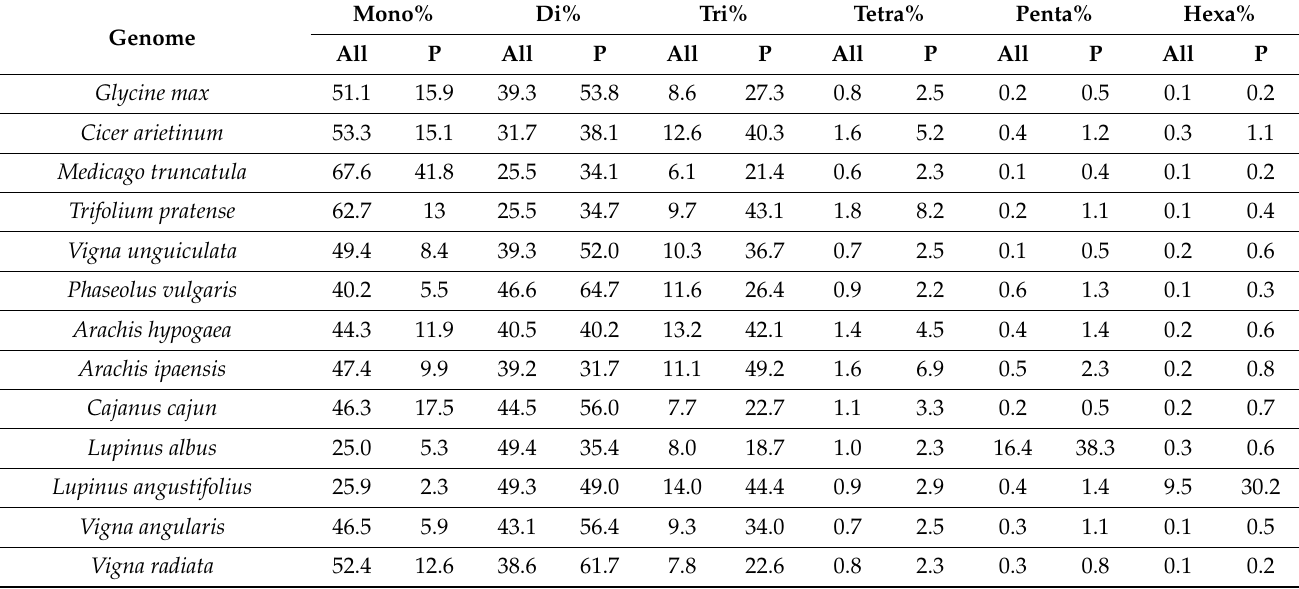
Table 2. Distribution of SSRs based on motif type. Where ‘All’ represents the percentage of all motifs in the genome, whereas ‘P’ represents the perfect motif-type